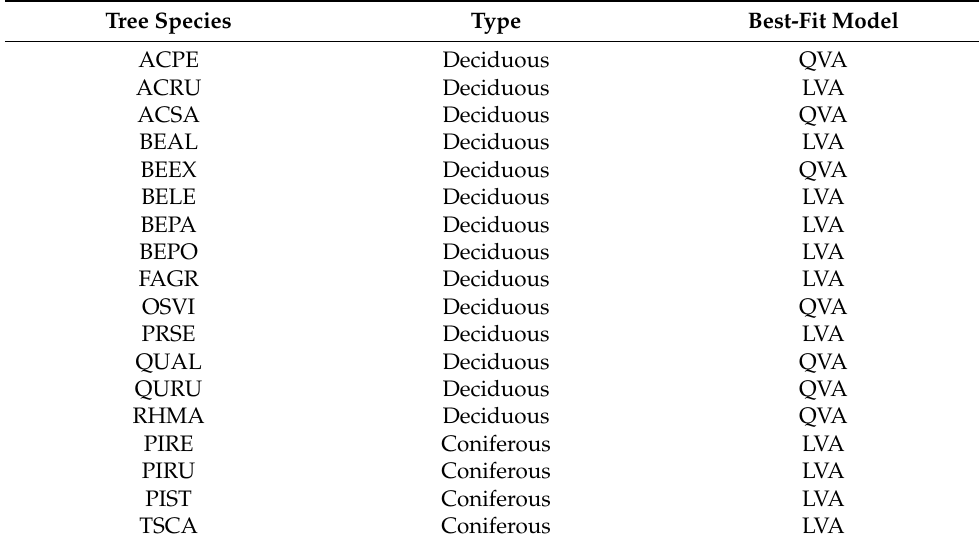
Table 2. Best-fit attenuation description for the forest stand of each species.